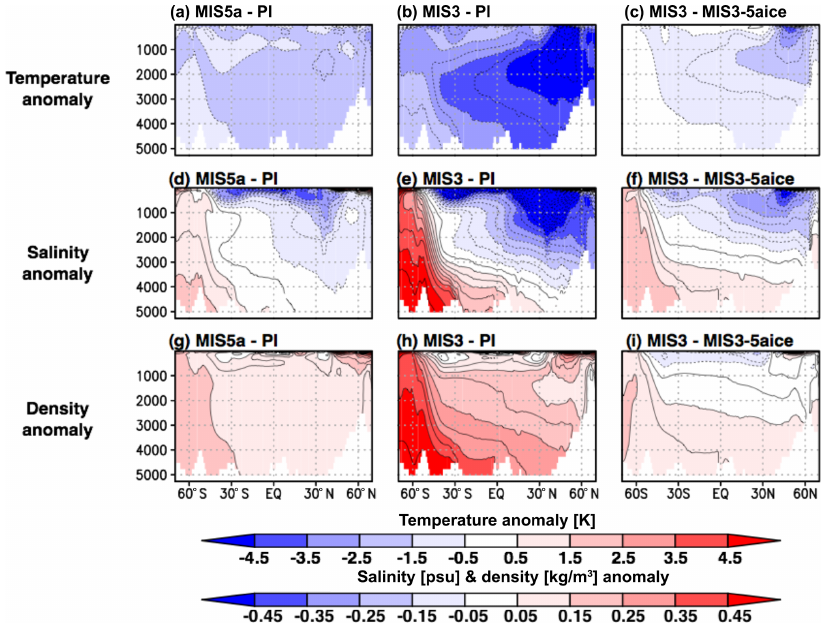
Figure 5. Anomalies of zonally averaged oceanic properties over the Atlantic simulated from the AOGCM. Panels (a) – (c) show temperature anomalies, panels (d) – (f) show salinity anomalies, and panels (g) – (i) show density anomalies. Panels (a) , (d) , and (g) show MIS5a minus PI, panels (b) , (e) , and (h) show MIS3 minus PI, and panels (c) , (f) , and (i) show MIS3 minus MIS3-5aice. The climatology of the last 100 years is used to create these figures.